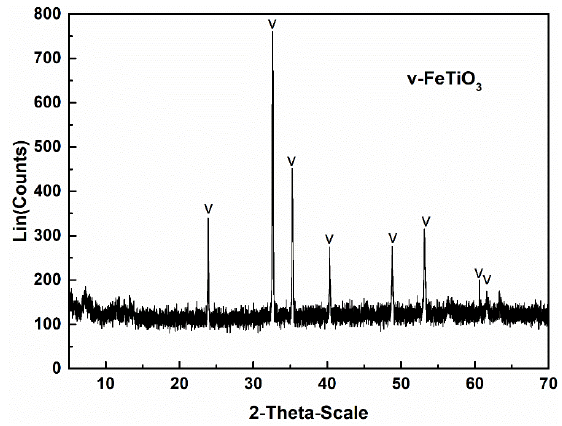
Figure 1. XRD pattern of the ilmenite.